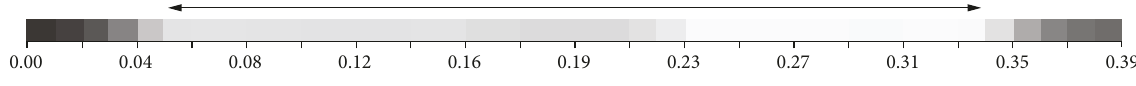
Figure 7: Guide to the color spectrum of feature maps.